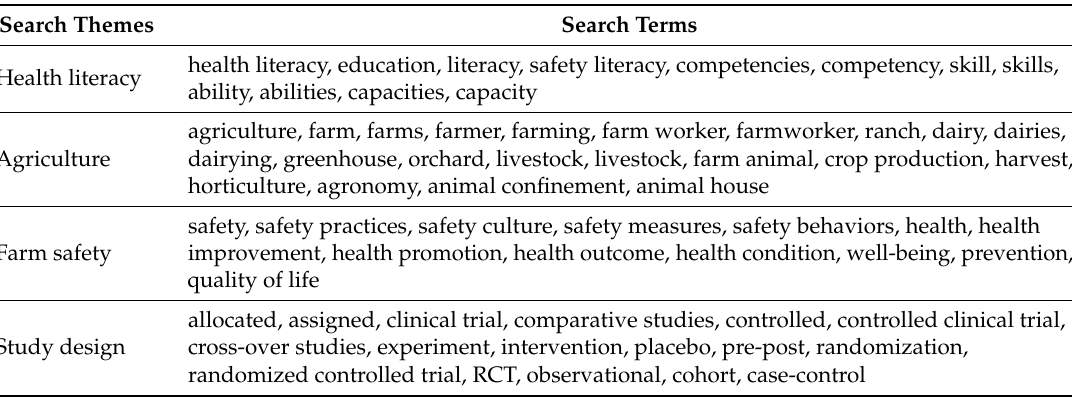
Table 1. List of search themes and terms used for the searching